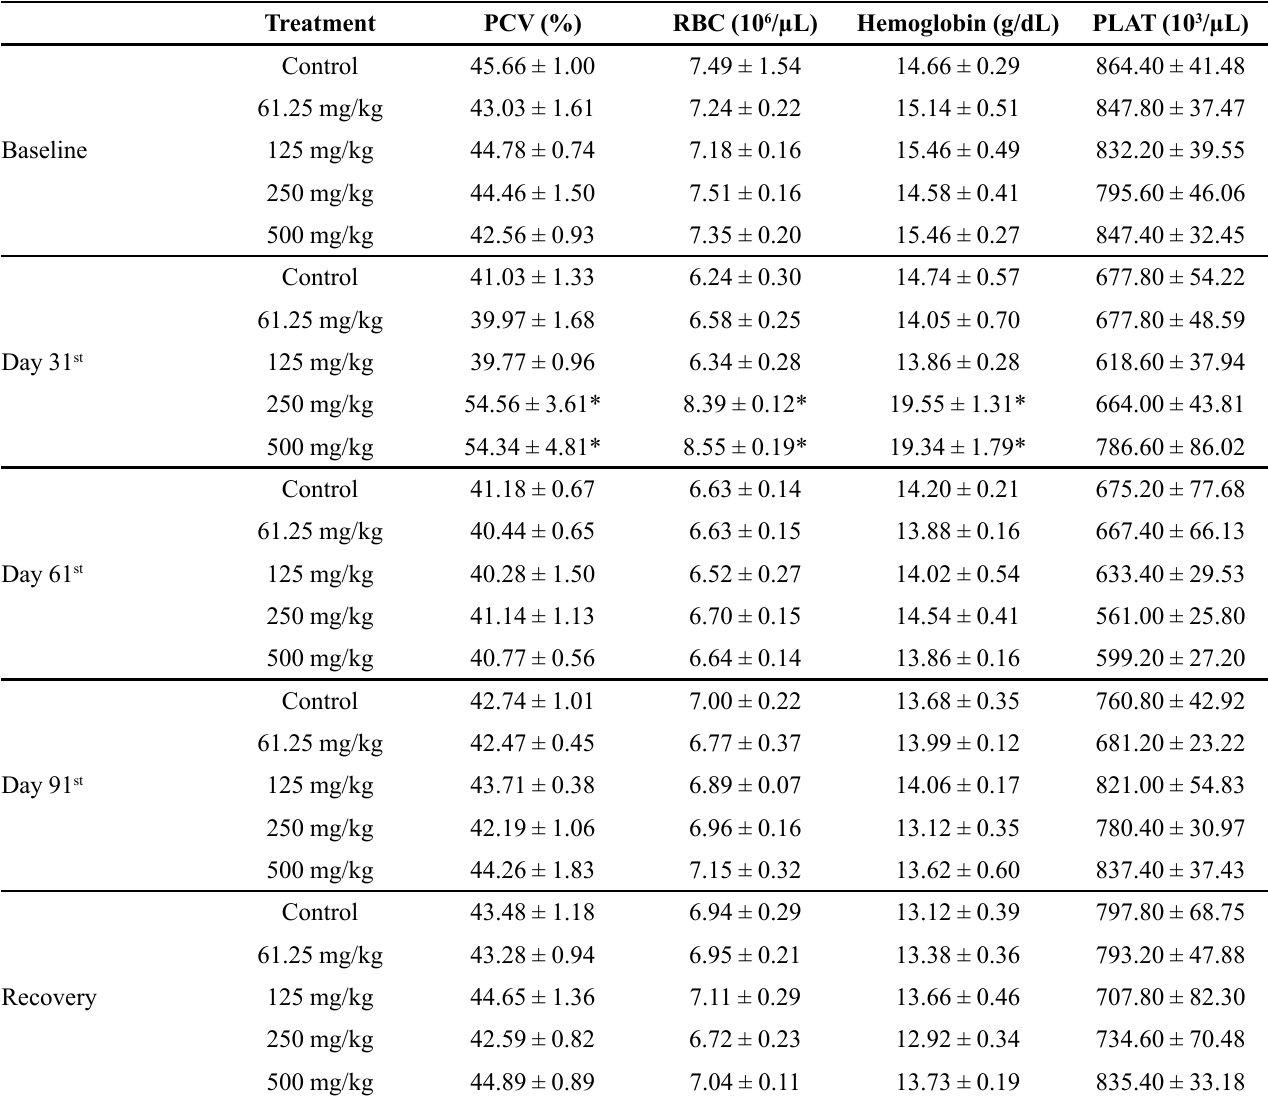
TABLE II - Effect of sub-chronic administration of Dryopteris filix-mas ethanol leaf extract on packed cell volume (PCV), red blood cell (RBC), hemoglobin and platelet (PLAT) levels of albino